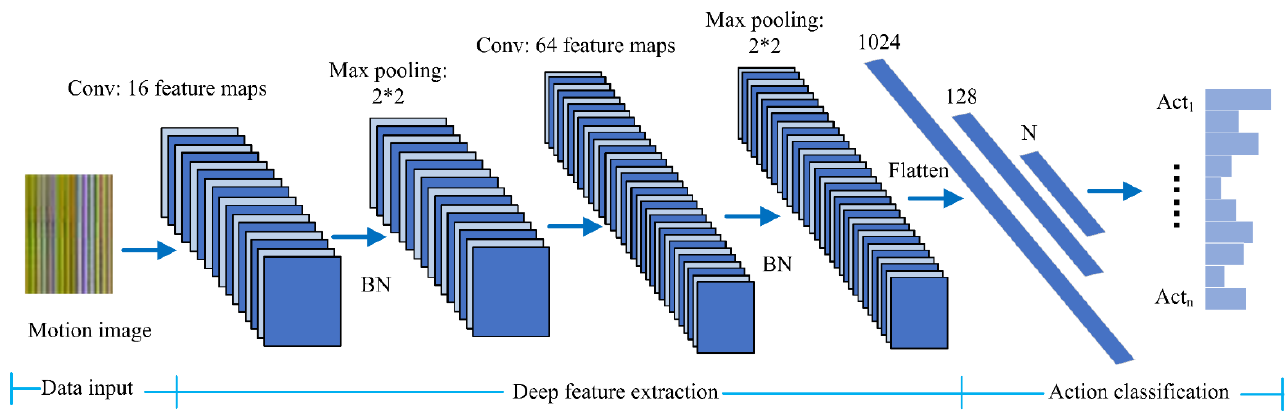
Figure 3. The CNN model is introduced for human action recognition in our proposed method. Conv represents convolutional layer, BN means the batch normalization layer, and N is the number of action categories.